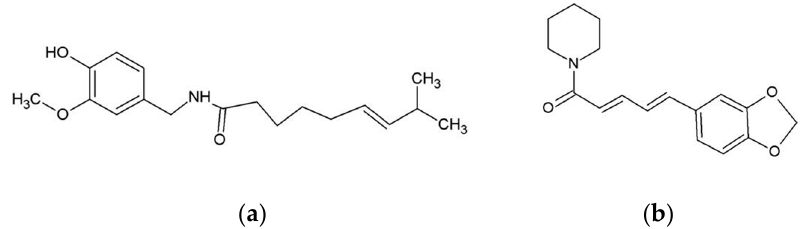
Figure 1. Chemical structures of ( a ) capsaicin and ( b ) piperine.